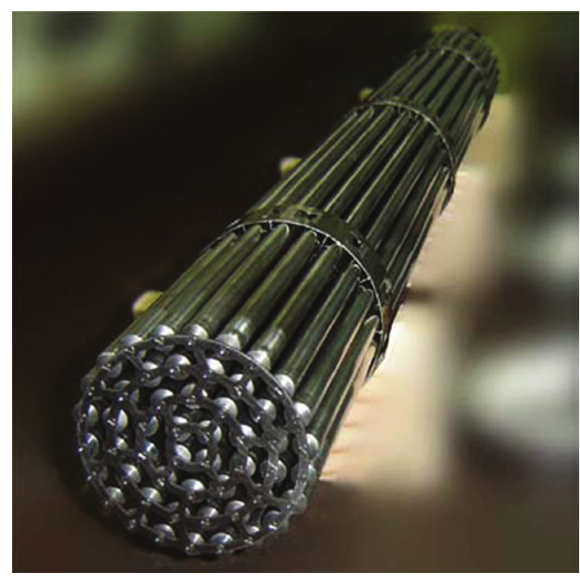
Figure 5: Cara fuel